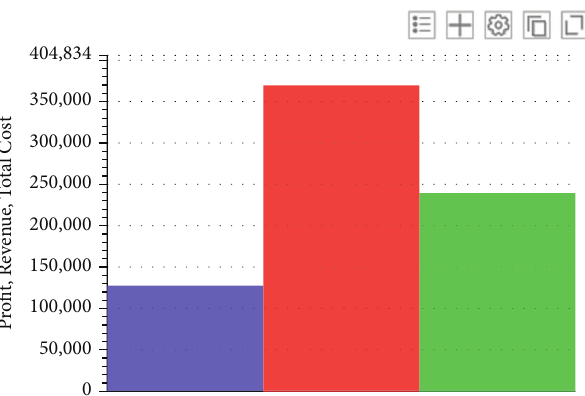
Figure 7: Profit, revenue, and total cost chart. Note: blue represents profit; red represents revenue; green represents total cost.